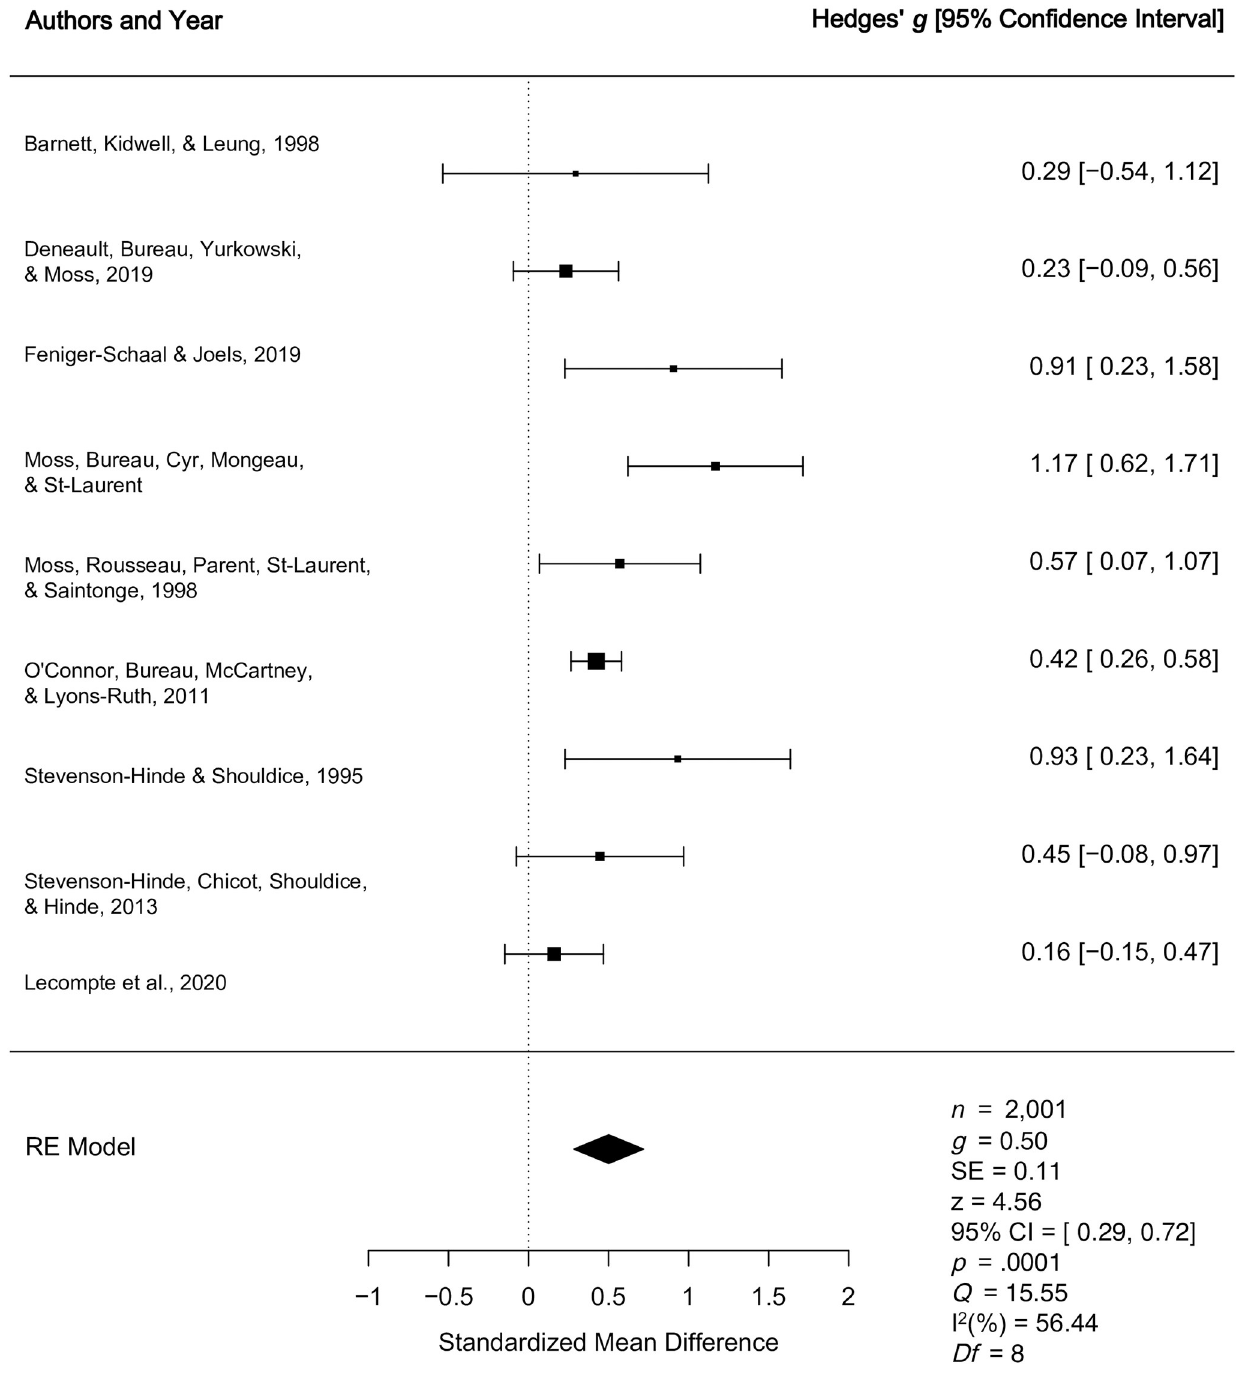
Fig 8. Forest plot for the concurrent relationship between unidimensional caregiver sensitivity and organized versus disorganized preschool attachment. RE = Random Effects Model; g = Hedges’ g; Q = Cochran’s heterogeneity statistic; Q; I 2 = percentage of variability across studies that is due to between-study